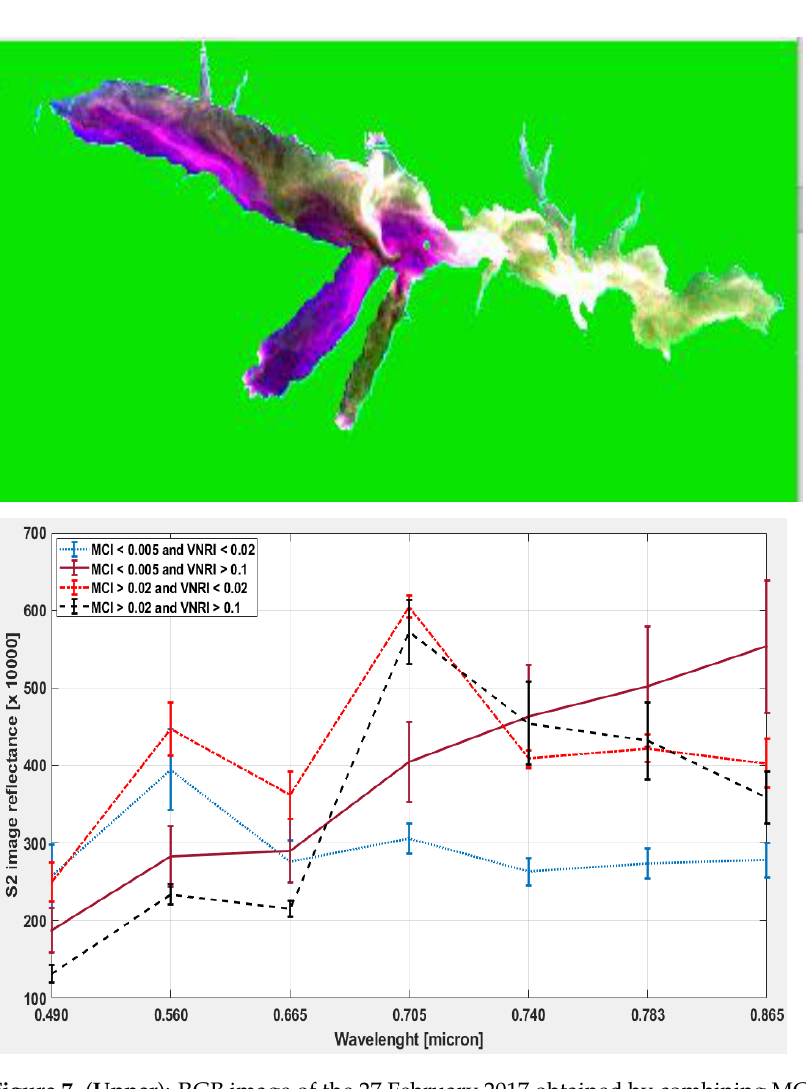
Figure 7. Upper : RGB image of the 27 February 2017 obtained by combining MCI map (R), VNRI Figure 7. ( Upper ): RGB image of the 27 February 2017 obtained by combining MCI map (R), VNRI (G), and S2 band 4 (B). Lower : Spectral profiles corresponding to different conditions of the water (G), and S2 band 4 (B). ( Lower ): Spectral profiles corresponding to different conditions of the water in the lake. in the lake.